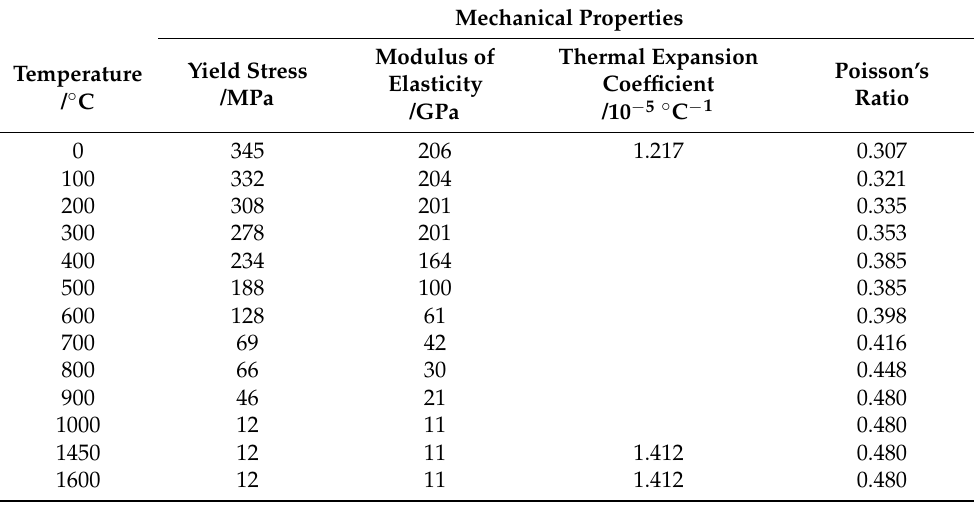
Table 3. Mechanical properties of S355J2 + N